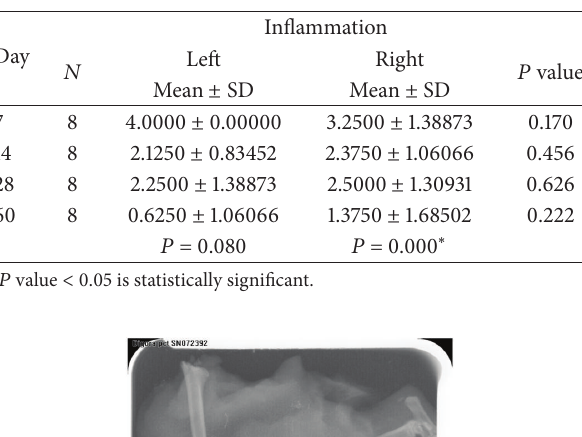
Table 2: Inflammation rate.